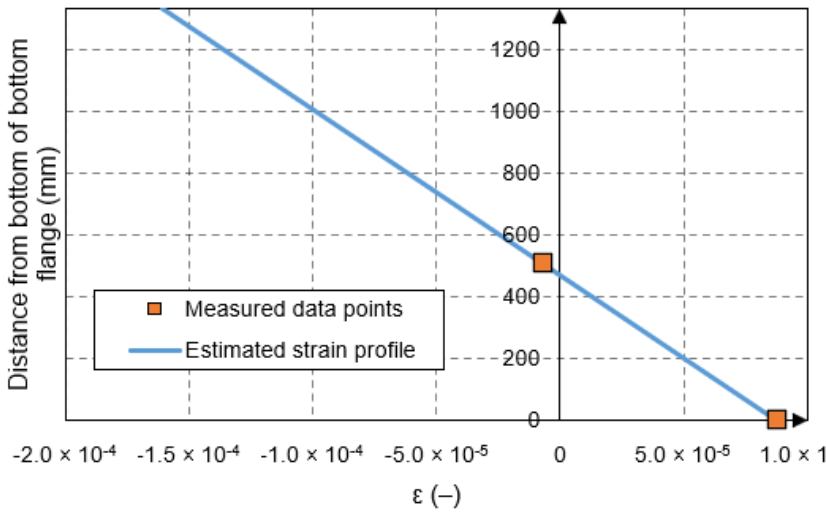
Figure 6. Strain profile of girder at transverse stiffener location.